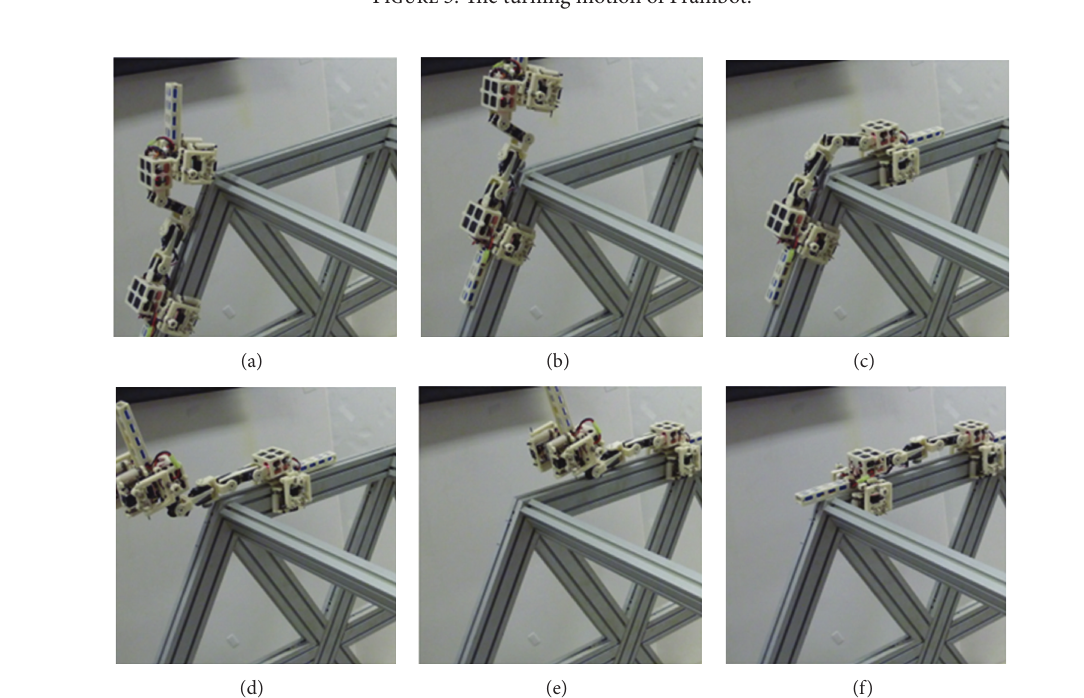
Figure 3: The turning motion of Frambot.